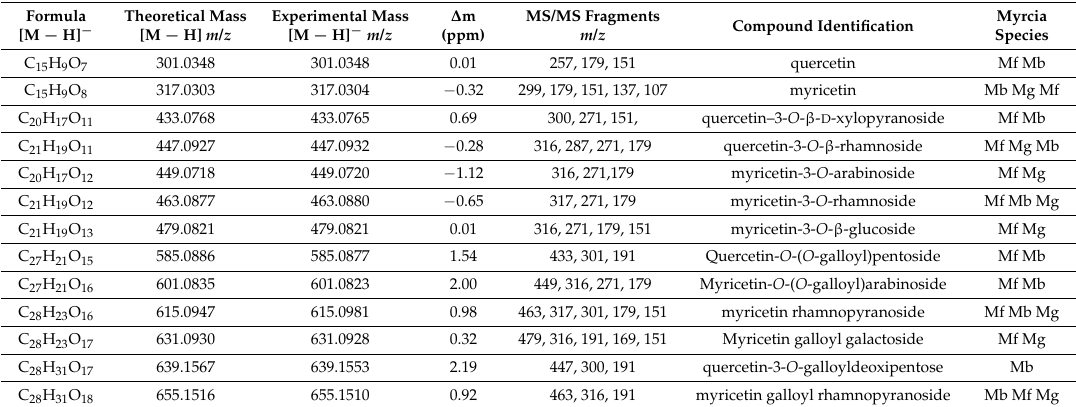
Table 2. Table 2. Flavonols identified from Myrcia sp. leaves